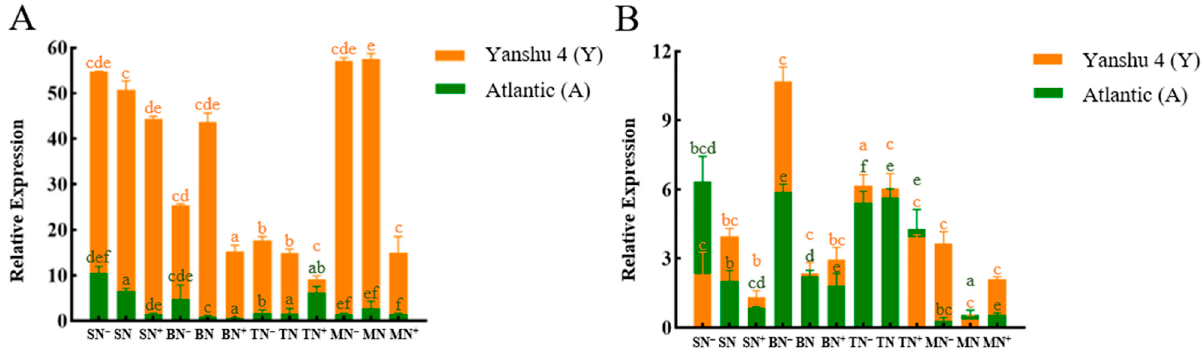
Figure 10. Relative expression of glutamate dehydrogenase gene StGDH in two genotypes of potato under different N supply levels. ( A ) Leaf (L); ( B ) Root (R). S, B, T, and M represent seedling stage, budding stage, tuber expansion stage, and mature stage, respectively. N − , N, N + are different N supply levels, representing low N, normal N, and excess N, respectively. Different letters indicate the difference of relative gene expression in different periods under different N application levels (p <